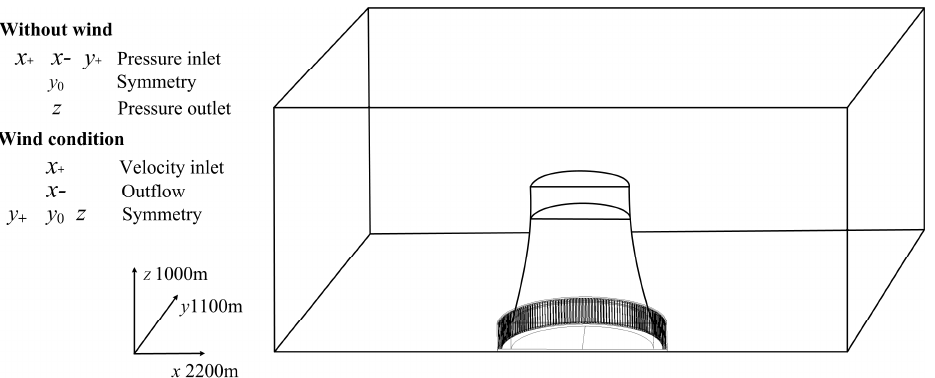
Figure 4. Numerical domain and boundaries.